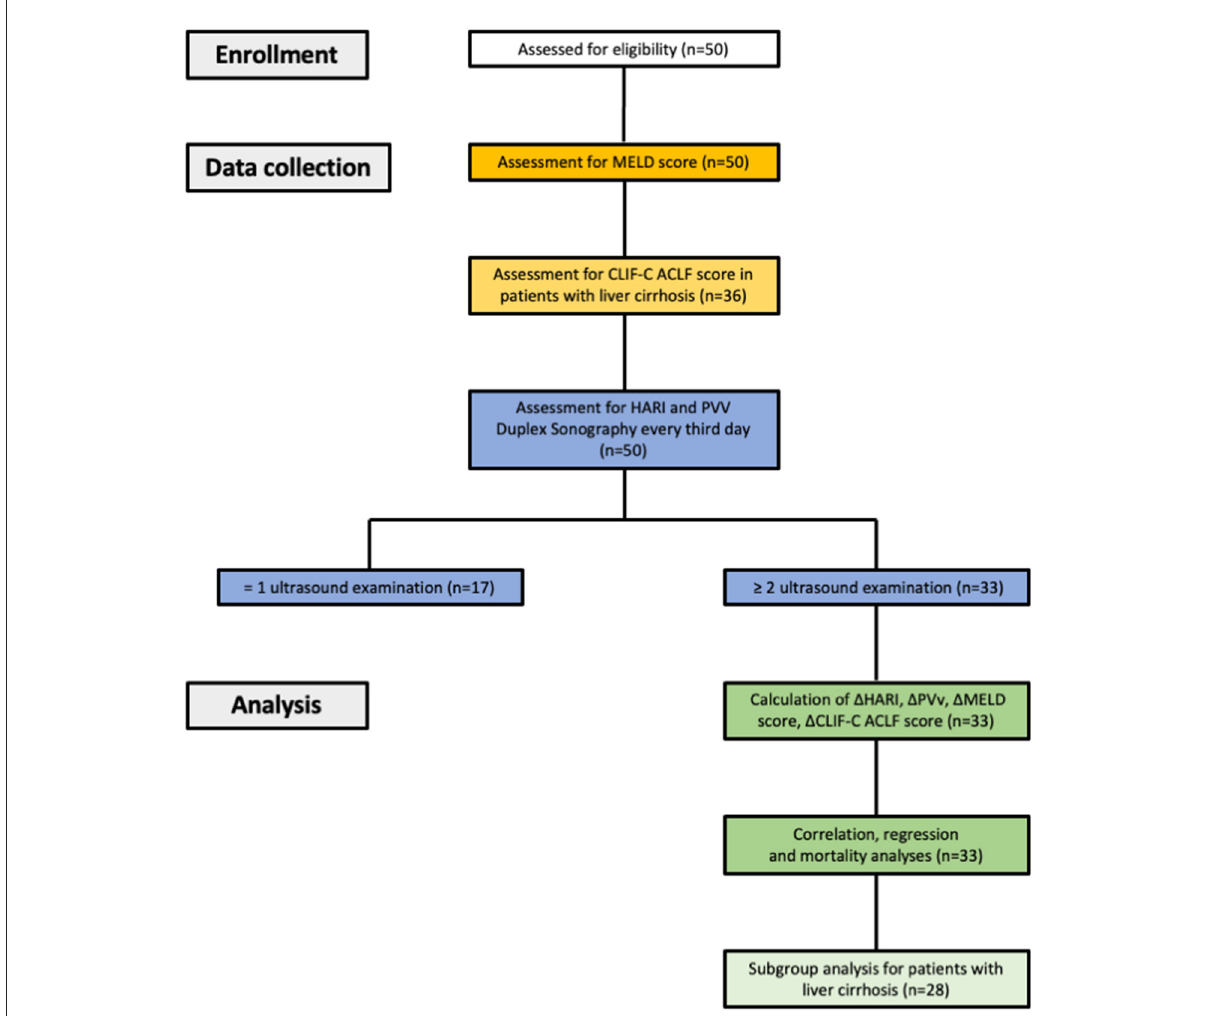
FIGURE1 Study design, data collection and data analysis. HARI, hepatic artery resistance index; PVv, portal vein velocity; CLIF-C ACLF score, chronic liver failure-consortium acute-on-chronic liver failure score.